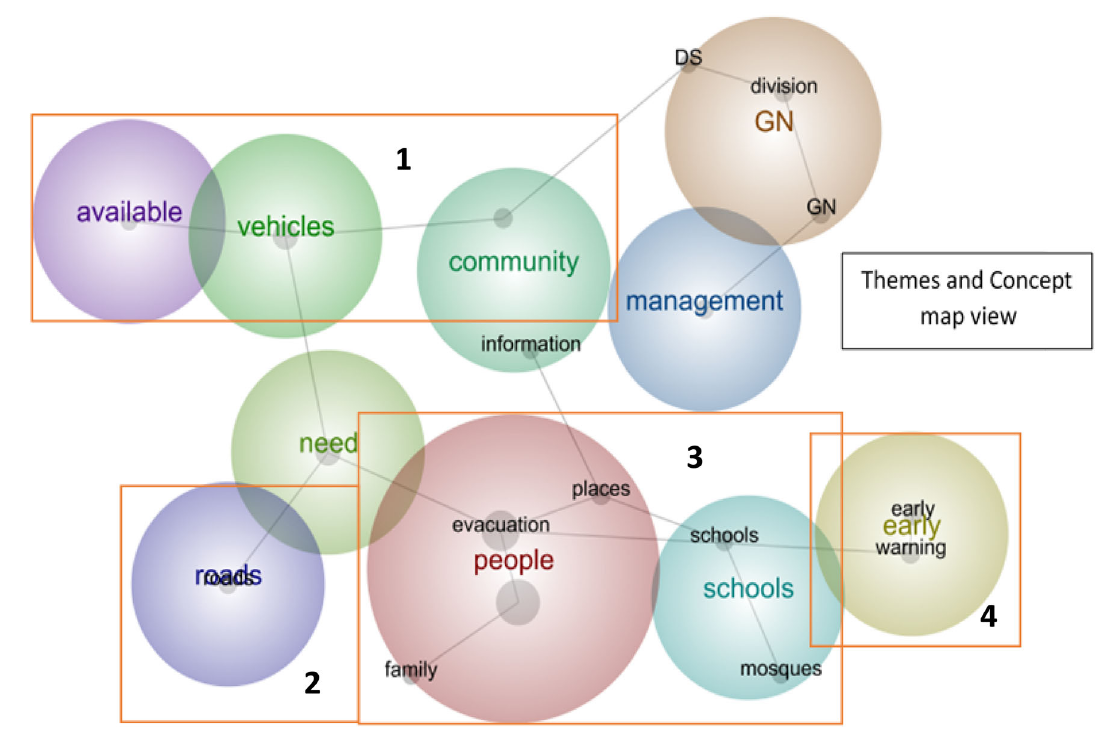
Fig. 7 Original Leximancer concept/theme map view from interview data of case study location #3, Kalmunai M Division (KMM). DS = Divisional Secretariate; GN = Grama Niladhari division. Con- cepts (shown as nodes and in smaller font size), themes (circle around